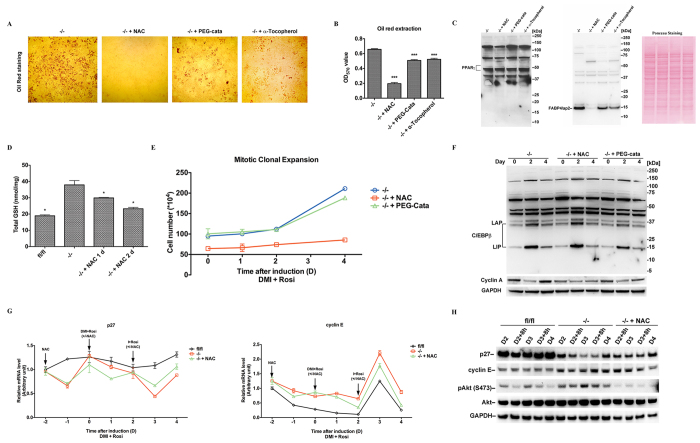
NAC treatment blocks adipocyte differentiation of Txnrd1−/− MEFs.(A) Confluent Txnrd1−/− MEFs were pretreated with 2 mM NAC, 100 U/ml PEG-catalase or 100 μM α-tocopherol for two days, before induction with standard adipocyte differentiation treatment and keeping the antioxidants present throughout the treatment for 8 days. The cells were subsequently stained with Oil Red-O; here 5x magnification was used for imaging. (B) The Oil Red-O staining was extracted and the color intensity was measured (n = 8, ±SEM), with significant differences between untreated controls and treated samples indicated (***P < 0.05). (C) Lysates of the MEFs in A were immunoblotted with antibodies against PPARγ and FABP4/aP2, with Ponceau S staining used as loading control. (D) GSH + GSSG levels (total GSH) were measured in Txnrd1fl/fl, untreated or 2 mM NAC treated Txnrd1−/− MEFs for time points as indicated (n = 3, ±SEM). Significant differences between untreated Txnrd1−/− MEFs and the other samples are indicated (*P < 0.05). (E) Confluent Txnrd1−/− MEFs were pretreated with 2 mM NAC or 100 U/ml PEG-catalase for two days, before they were induced with adipocyte differentiation treatment with the antioxidants present. Cell numbers at different time points after induction were determined and plotted (n = 4, ±SEM). (F) The cell lysates of the different time points in E were immunoblotted with antibodies against C/EBPβ and cyclin A, with GAPDH as loading control. (G) Confluent Txnrd1−/− cells were incubated with 2 mM NAC for two days and then induced with adipocyte differentiation treatment as described for indicated time points in the NAC treated samples. Txnrd1fl/fl and Txnrd1−/− cells not treated with antioxidants were used for comparison. The mRNA levels of p27 and cyclin E at different time points were measured using real time-PCR and plotted by normalizing to 18 S (n = 3, ±SEM). (H) The cell lysates of the MEFs at different time points between day 2 (D2) and day 4 (D4) cultured as in (G) were immunoblotted with antibodies against p27, cyclin E, pAkt (S473) and total Akt, with GAPDH used as loading control. See Supplementary Material for non-cropped immunoblots.